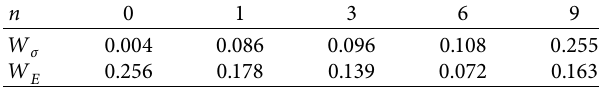
Table 3: The value of W for the different